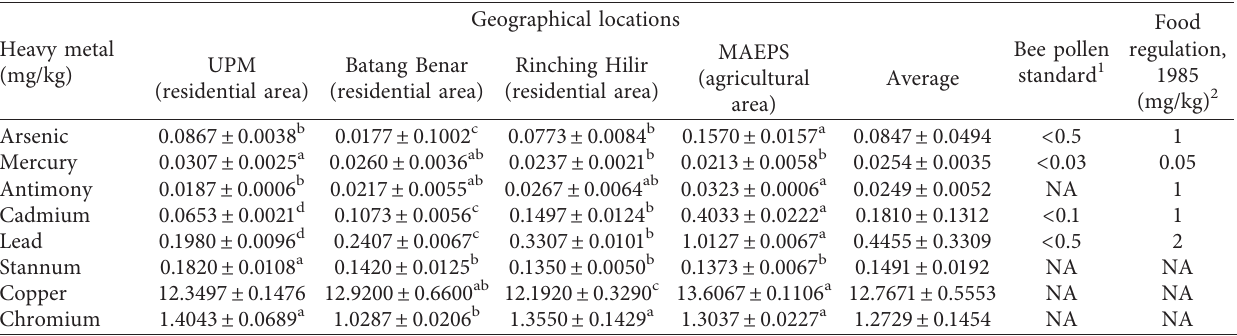
Table 7: Heavy metal (mg/kg) composition in H. itama bee bread and comparison with the maximum acceptable level of